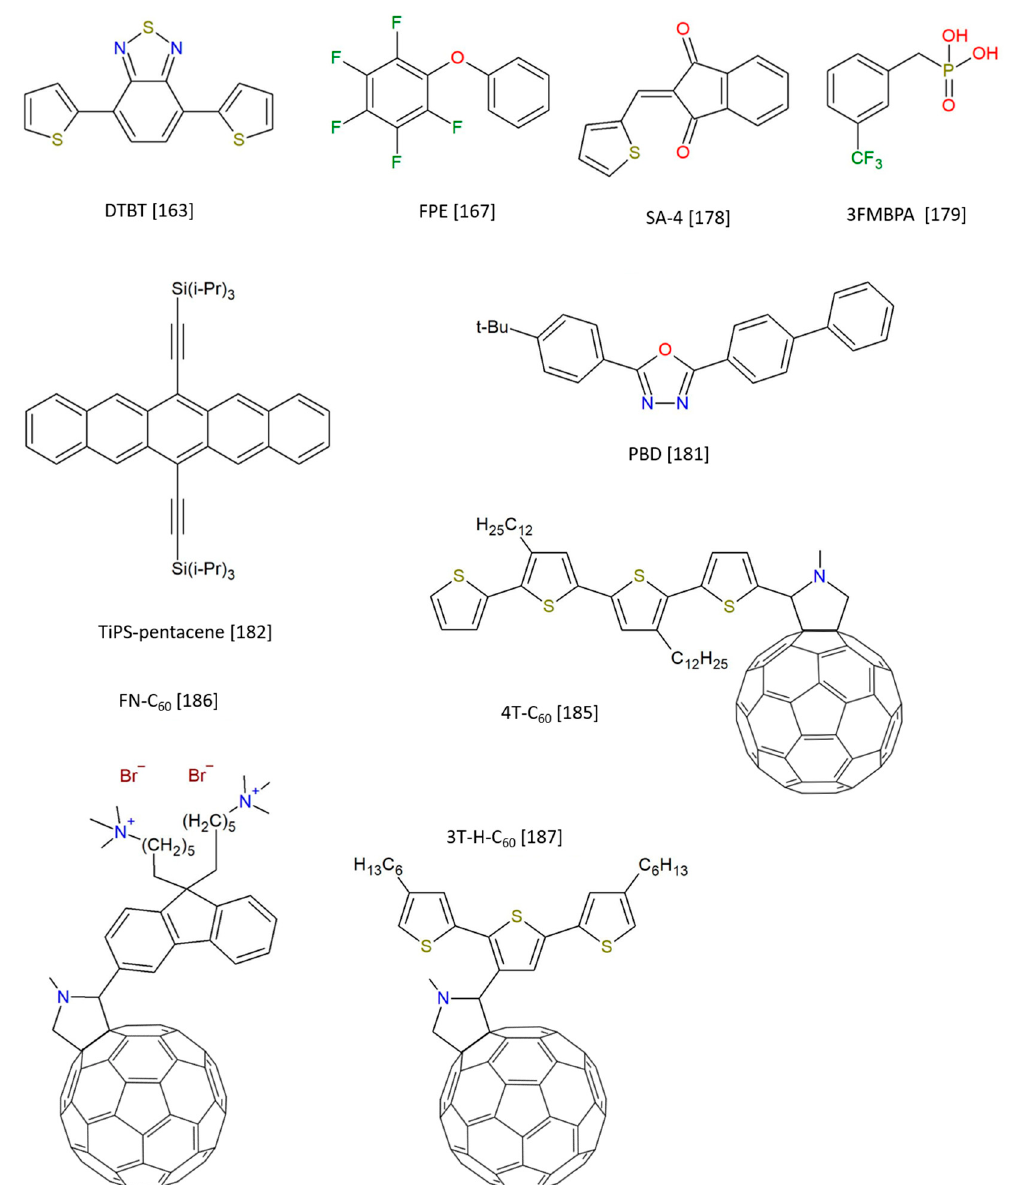
Figure 9. A pictorial collection of the most representative small-molecule-based CBs described in the subsequent sections. CBs are named according to the label provided by the authors in the cited article.